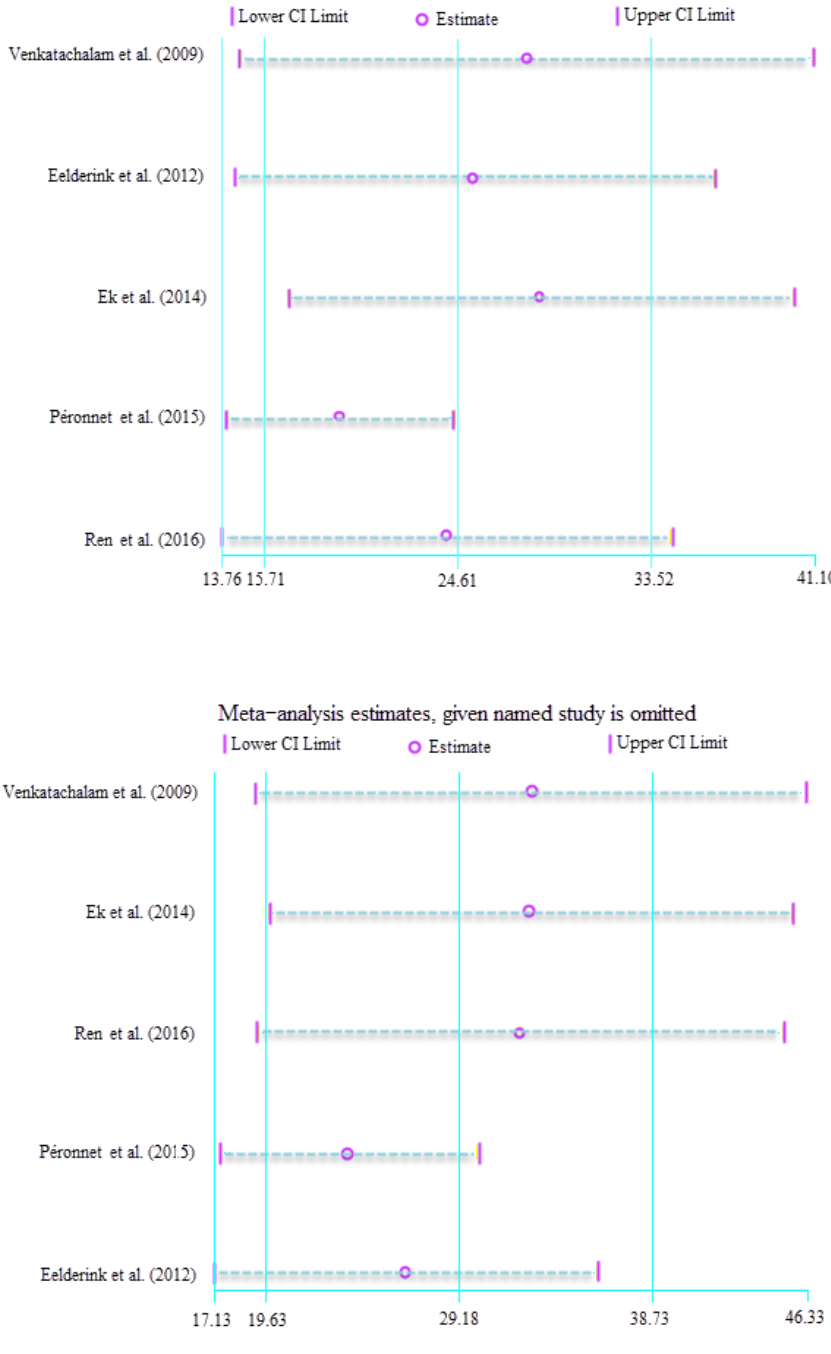
Figure 3. Sensitivity analysis of SDS intake and EGI ( top ), GP ( bottom )[10,14 –